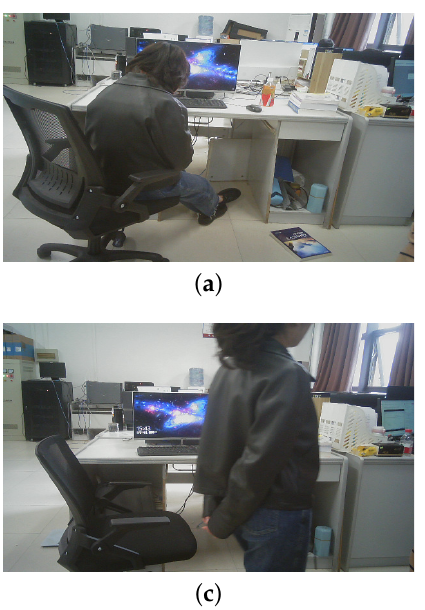
Figure 10. Static Semantic Map of Dynamic dataset: ( a ) dense point cloud map of low dynamic dataset; ( b ) our algorithm results in a low dynamic dataset; ( c ) dense point cloud map of a high dynamic dataset; ( d ) our algorithm results in a high dynamic dataset.